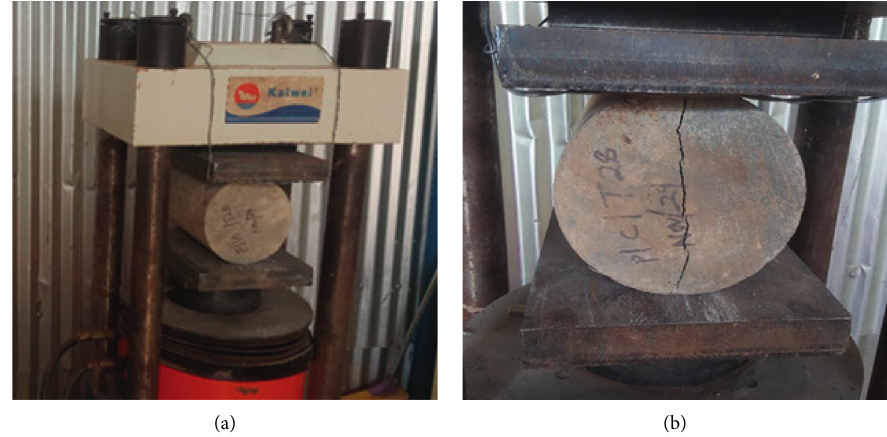
Figure 5: Splitting tensile strength testing. (a) Splitting tensile strength test setup. (b) Failure mode of concrete under splitting tension.